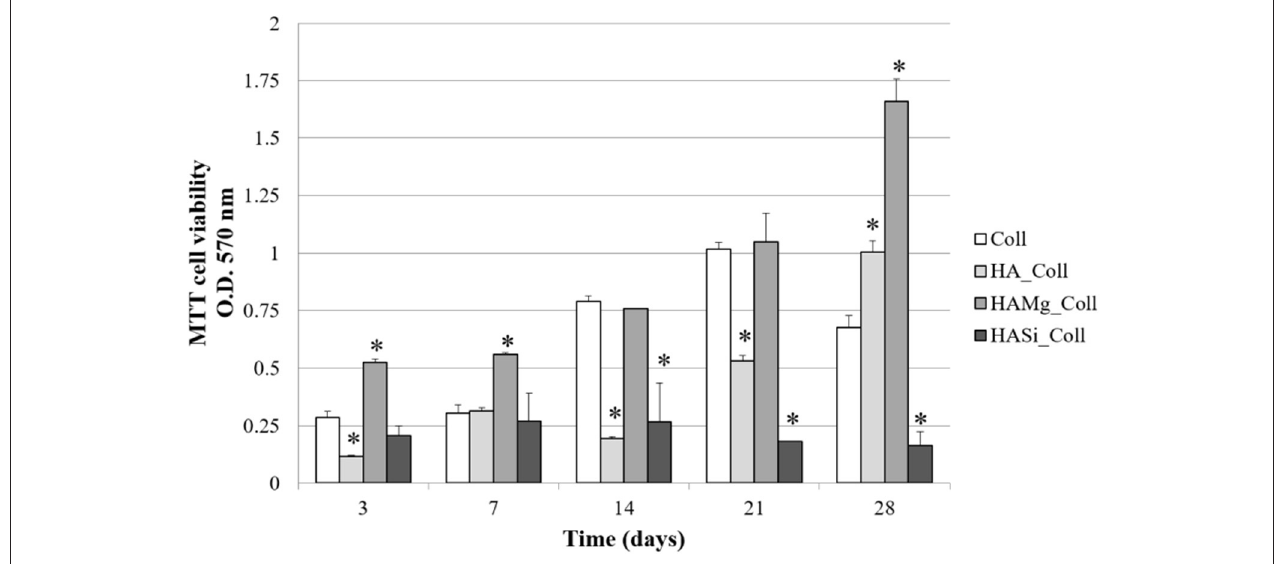
FIGURE 6 | Viability of BMSC on Coll, HA_Coll, HA-Mg_Coll, and HA-Si_Coll scaffolds assessed by MTT assay after 3, 7, 14, 21, and 28 days of cell seeding. Collagen scaffolds (Coll) are used as control. Data represent the means ± SD of duplicate measurements from three independent experiments. * P <